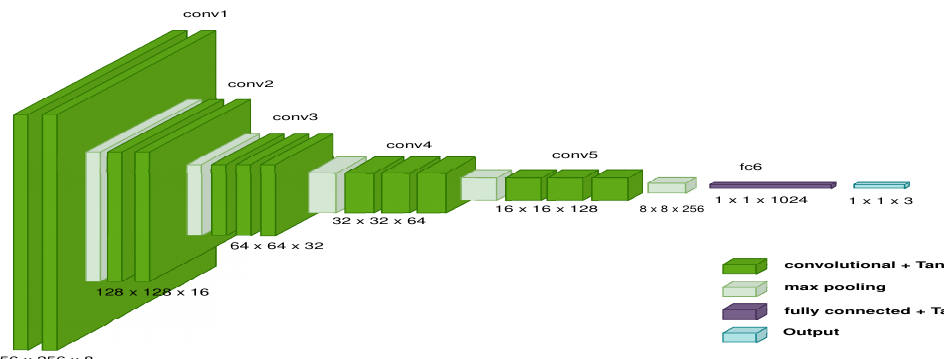
Figure 5. Features of the DCNN model to describe samples in a 3D space.